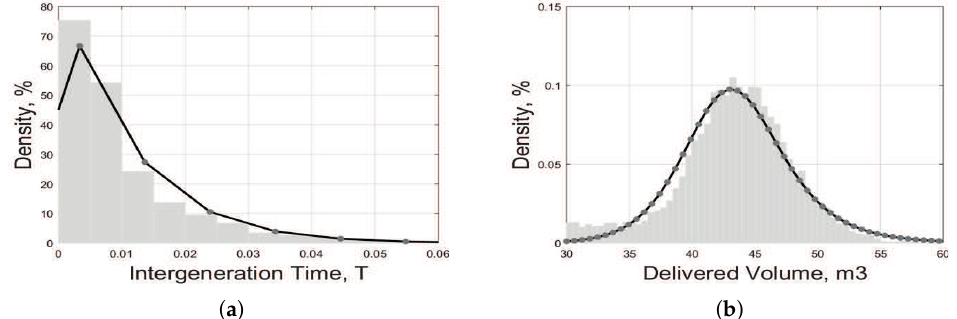
Figure 9. Data fitting of intergeneration time ( a ) and attribute for delivered log volume ( b ). Where the grey area is a empirical data from company and bold line is showing fitting of the